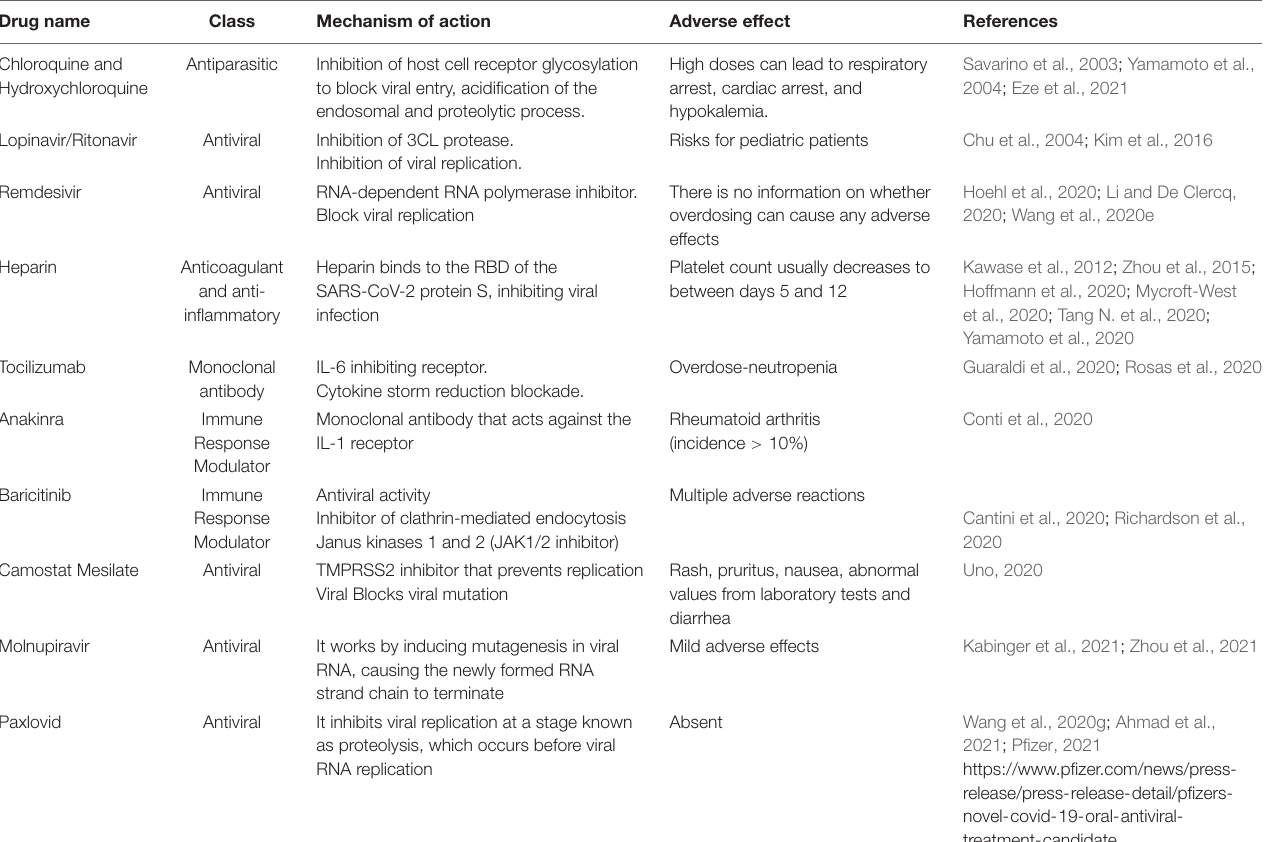
TABLE 5 | Medicines used in the treatment of